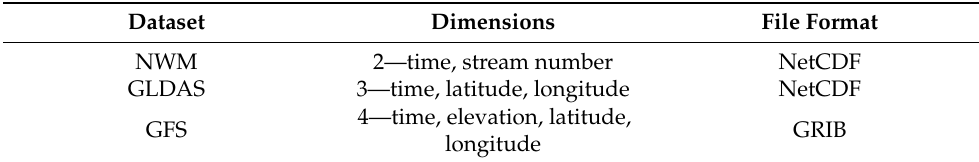
Table 3. Summary of Test Dataset Properties.